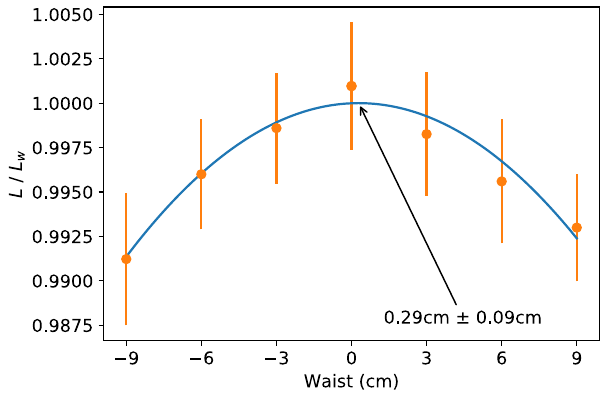
FIG. 15. Luminosity scan of Beam 2 on the vertical plane.